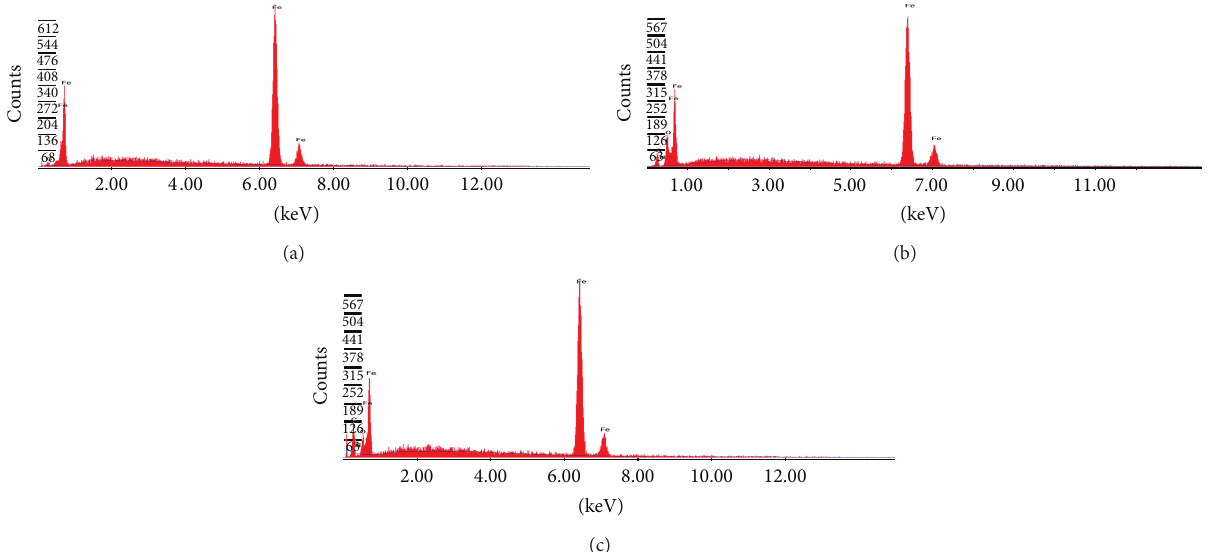
Figure 12: EDX images of (a) polished MS surface, (b) MS in 500 ppm INIMH, and (c) MS in 500 ppm INPMH.